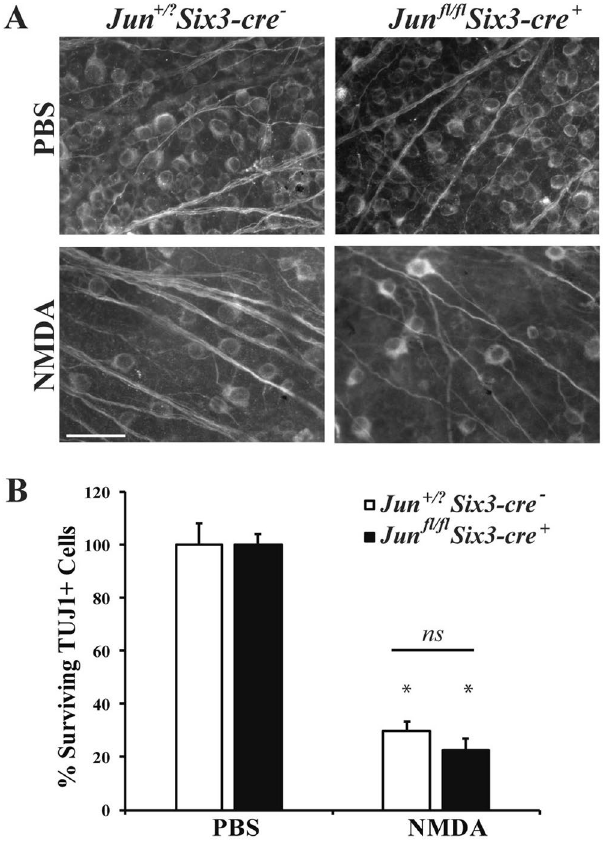
Figure 7. Deficiency of JUN does not protect RGCs after excitotoxic injury. To determine if JUN is required for NMDA induced RGC death, NMDA was injected into the vitreous of Jun deficient ( Jun fl/fl ; Six3-cre + ) mice. The number of surviving RGCs (TUJ1 + cells) were counted 7 days after intravitreal NMDA injection. ( A ) Representative images from flat mounted retinas stained with anti-TUJ1 show significant RGC loss in both wildtype ( Jun + /? ; Six3-cre − ) and Jun fl/fl ; Six3-cre + mice after NMDA insult (n = 5 for PBS WT, n = 5 for NMDA WT, n = 6 for PBS Jun fl/fl ; Six3-cre + , n = 5 for NMDA Jun fl/fl ; Six3-cre + ). ( B ) Quantification of TUJ1 + RGCs confirmed that Jun deficient mice had a similar loss of RGCs compared to wildtype mice 7d after NMDA injection ( * p < 0.001, comparing 20 mM NMDA to PBS control; p = 0.9846 comparing WT to Jun fl/fl ; Six3-cre NMDA; ns between genotypes). Scale bar: 50 μ